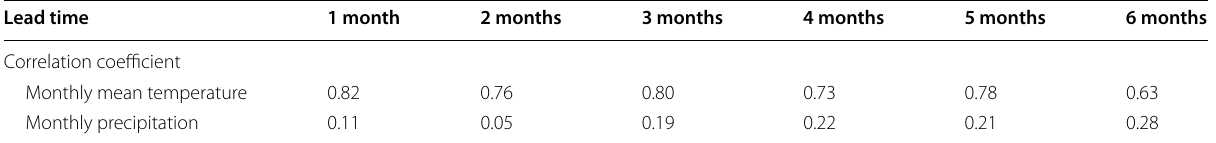
Table 8 Correlation coefficient of the prediction models based on teleconnection according to lead time Lead time 1 month Correlation